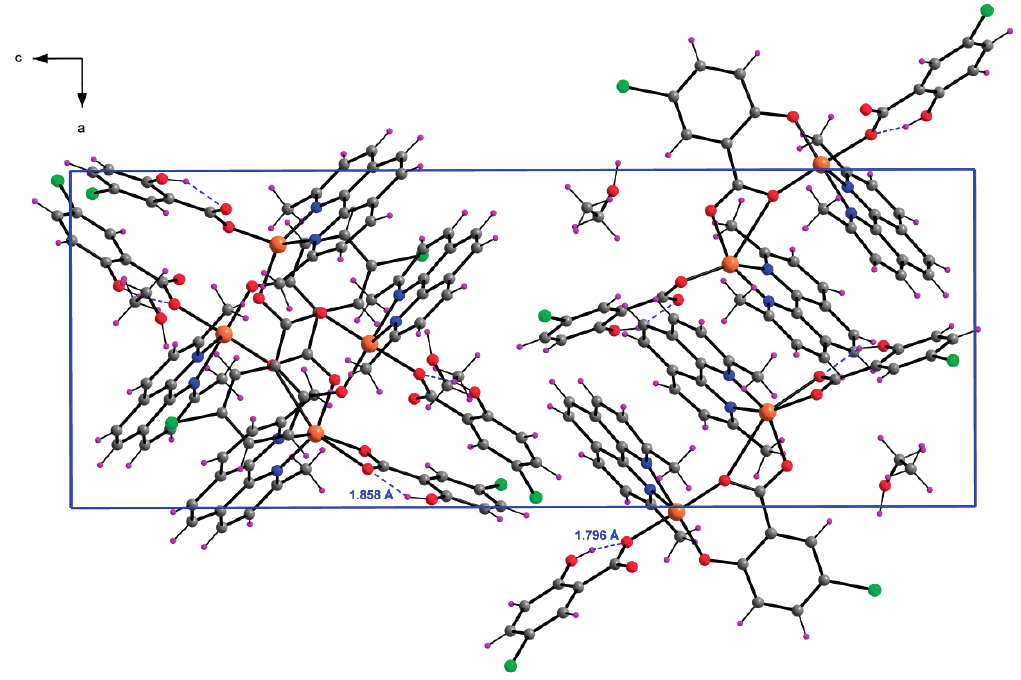
Figure 5. View of the packing of 3 in the unit cell with intramolecular hydrogen bonds (dashed blue